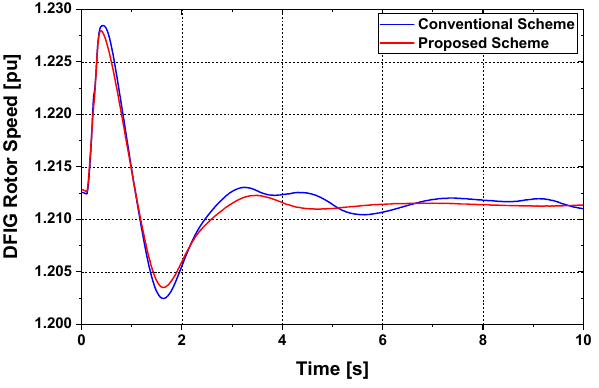
Figure 16. Active Power response of DFIG.